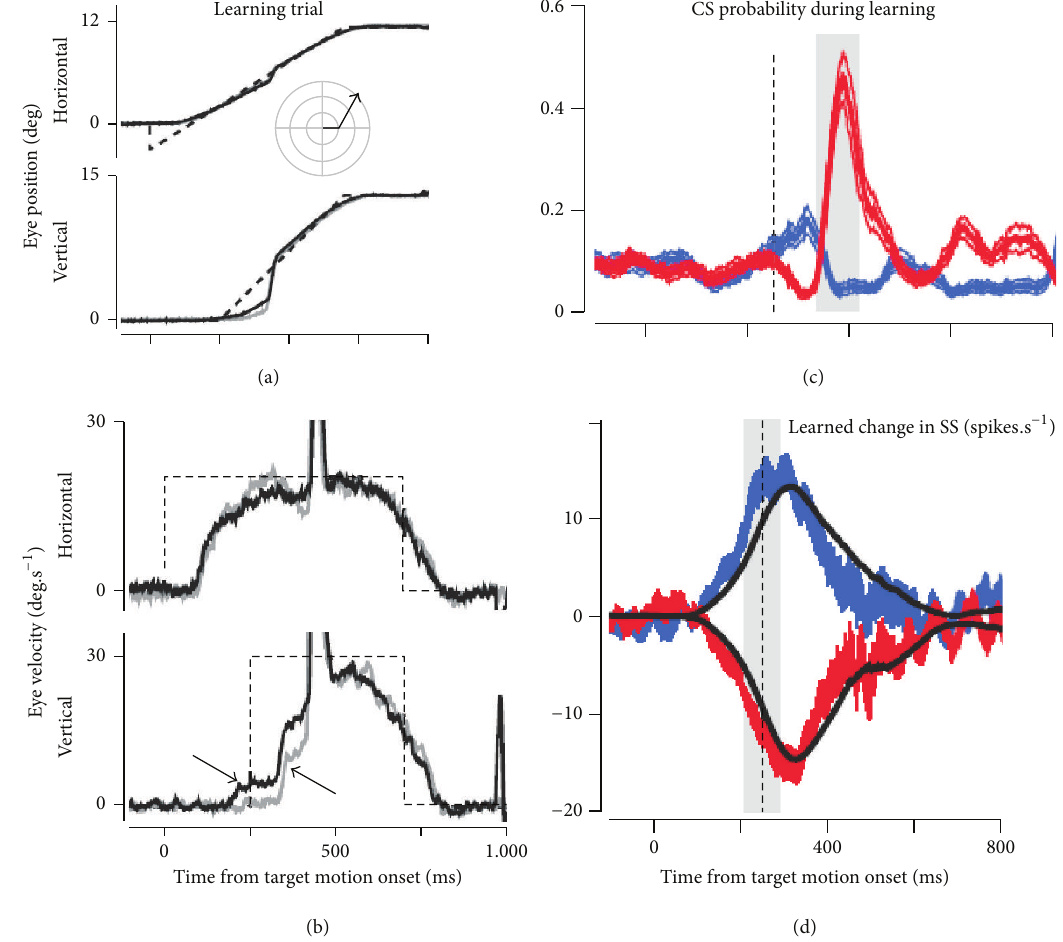
Figure 4: Directional learning during pursuit eye movements. (a) Representative eye movement during pursuit of a target moving first toward the right and then in oblique upward direction, the inset indicates the target motion in polar coordinates. (b) Eye velocity trace of the movement illustrated in (a). Gray and black traces indicate data from representative trials before learning and after at least 100 learning trials, respectively. The dashed traces indicate the velocity step signal of the target motion. Note that the vertical step (lower part) delayed the horizontal one (upper part) by 250ms. The arrow pointing down and right indicates the learned response. The arrow pointing up and left indicates the hardwired visual response to the change in target direction, ( adapted from [83] with permission